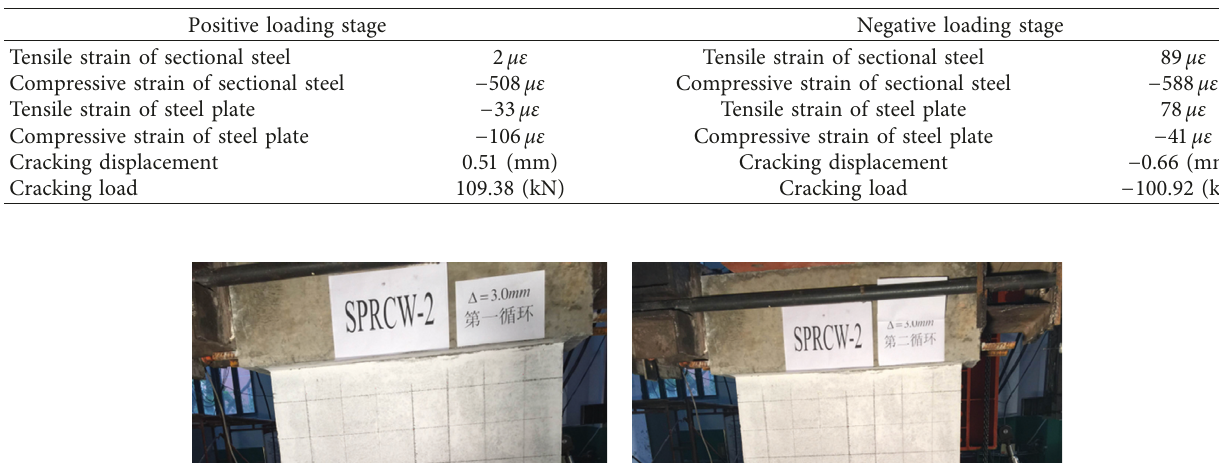
Table 6: Test data of the SPRCW-2 test piece in the load control stage.